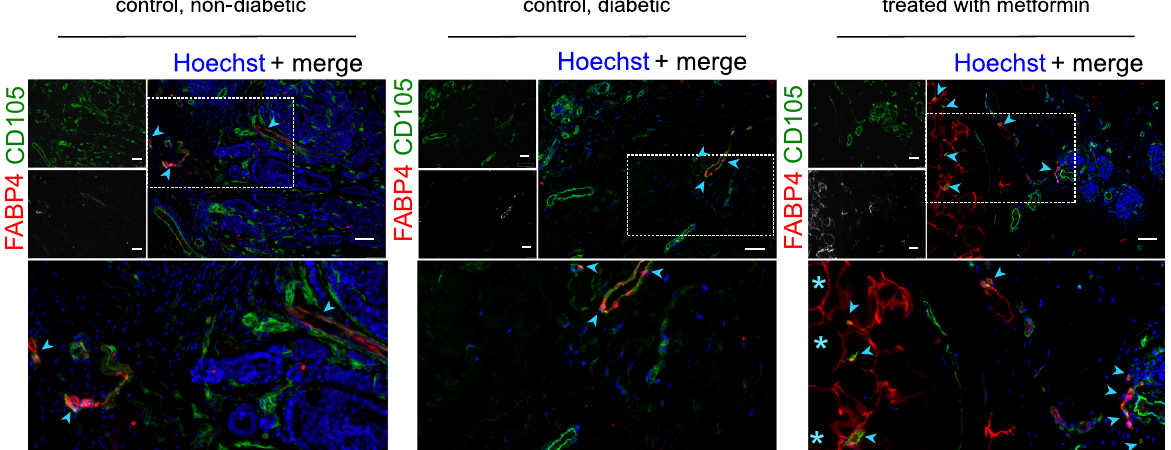
Fig. 6 | Lipid processing endothelial cells — translational implications. a Schematic overview of the survival analysis in the retrospective clinical cohort and immunostaining validation. UH university hospital, BC breast cancer, HER2 human epidermal growth factor receptor 2, BMI body mass index, HR hormone receptor status. Color coding in the clinical characteristics panel re fl ects differ- ences in age, BMI, tumor stage & grade (Supplementary Data 6). Color coding underneath the treatmentstrati fi cation panelindicatespatientsthat did (green) or did not (blue) receive metformin treatment during follow up. b Cumulative inci- dence function estimate of BC-speci fi c survival (left panel) and the distant relapse free interval (right panel) in BC patients strati fi ed by intake of a metformin. Color coded by group: blue – control, green – patients treated with metformin, purple – controlmatchedforage,BMI,tumorstage&gradeandhormonereceptorstatus. P - values were calculated by the Kaplan – Meier (log rank) test between metformin therapy and without metformin therapy groups (blue for unmatched control